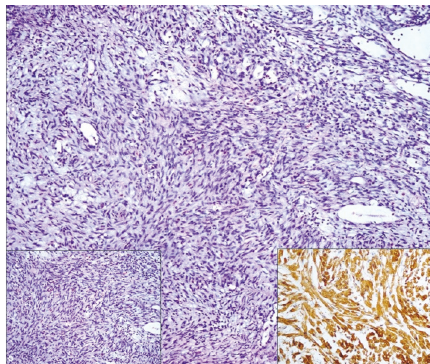
Figure 2: Spindle cell lesion in resection specimen (H&E stain, 100x). No atypia, left inset (H&E stain, 200x). Positive expres- sion with smooth muscle actin immunohistochemistry, right inset (100x).